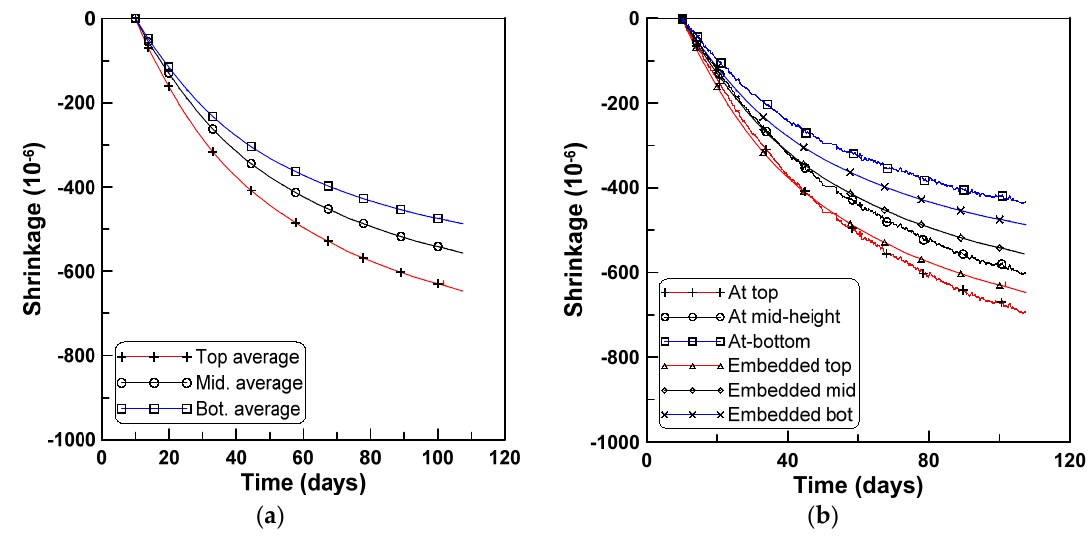
Figure 10. Average shrinkage strains obtained from embedded strain gages (test series C): ( a ) Shrinkage strain measurements; ( b ) comparison with surface-attached gage measurements.